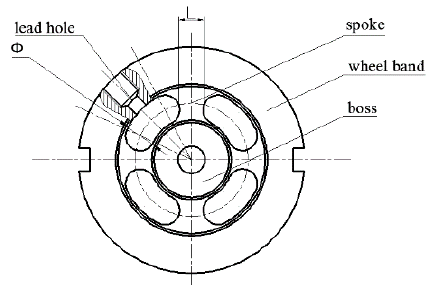
Figure 3. Spoke structure of sensor elastomer.